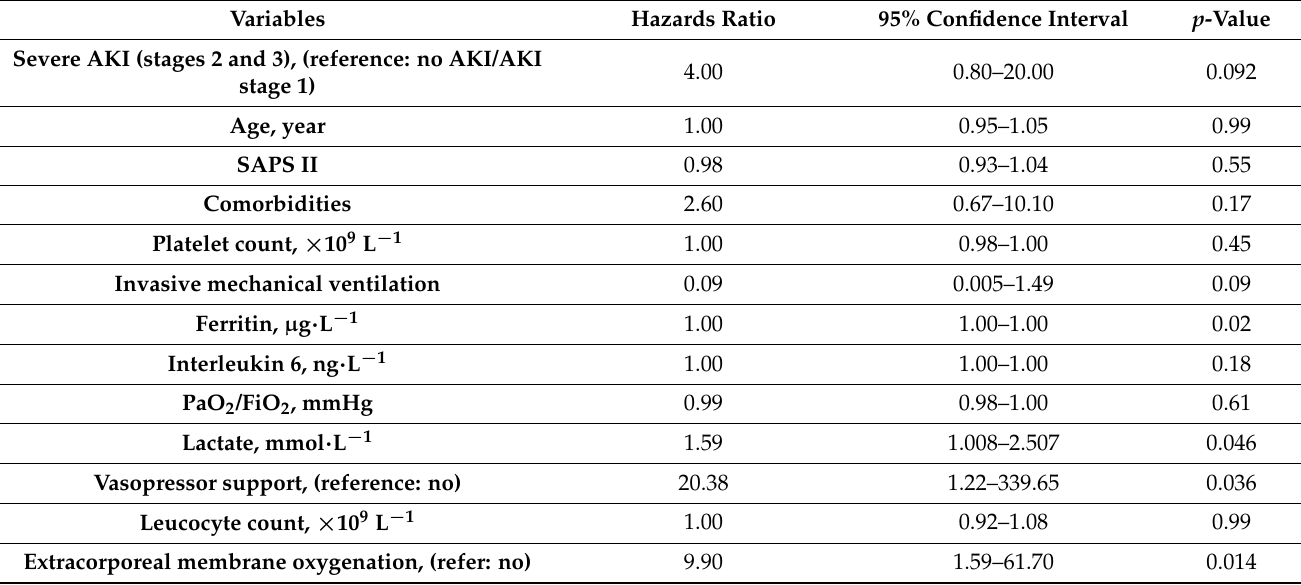
Table 5. Factors associated with hospital mortality (multivariable Cox regression analysis).